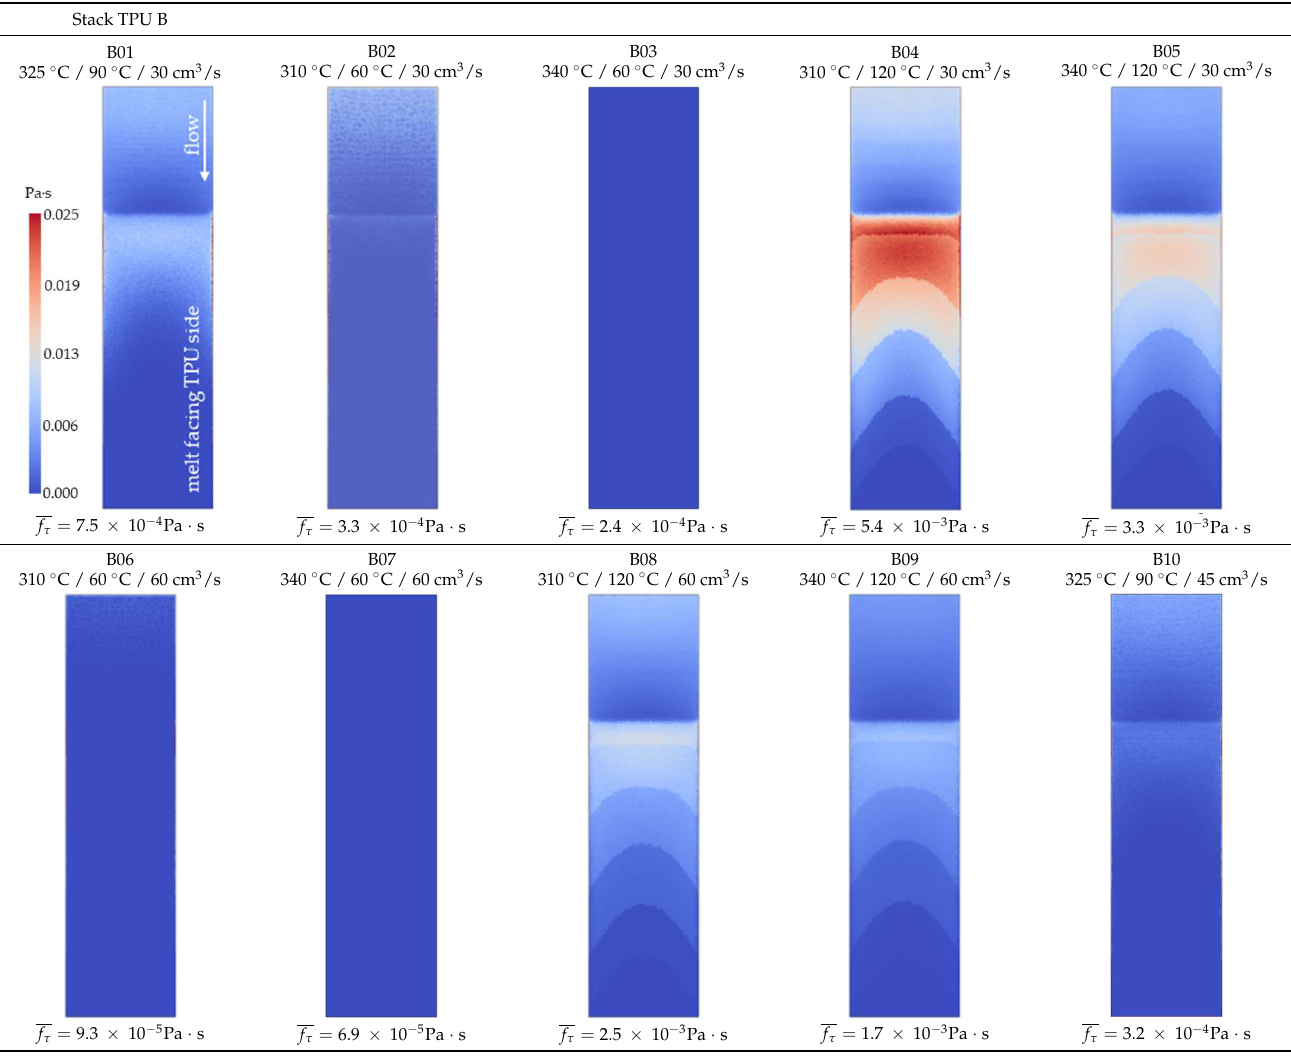
Table 6. Shaded contour plots of the calculated shear distortion factor for film strips using TPU P for molding settings as outlined in Table 1.